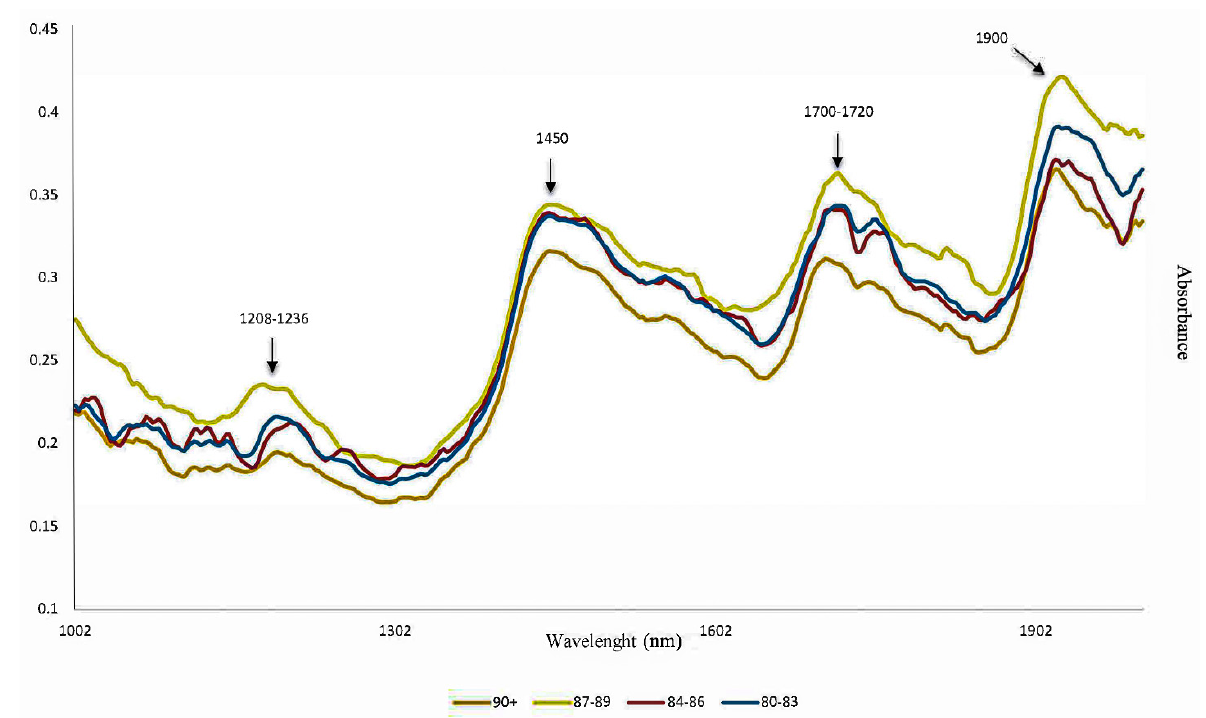
Figure 2. Full NIR spectra (1000–2000 nm) obtained for roasted coffee (colors are related to sensory quality scores.